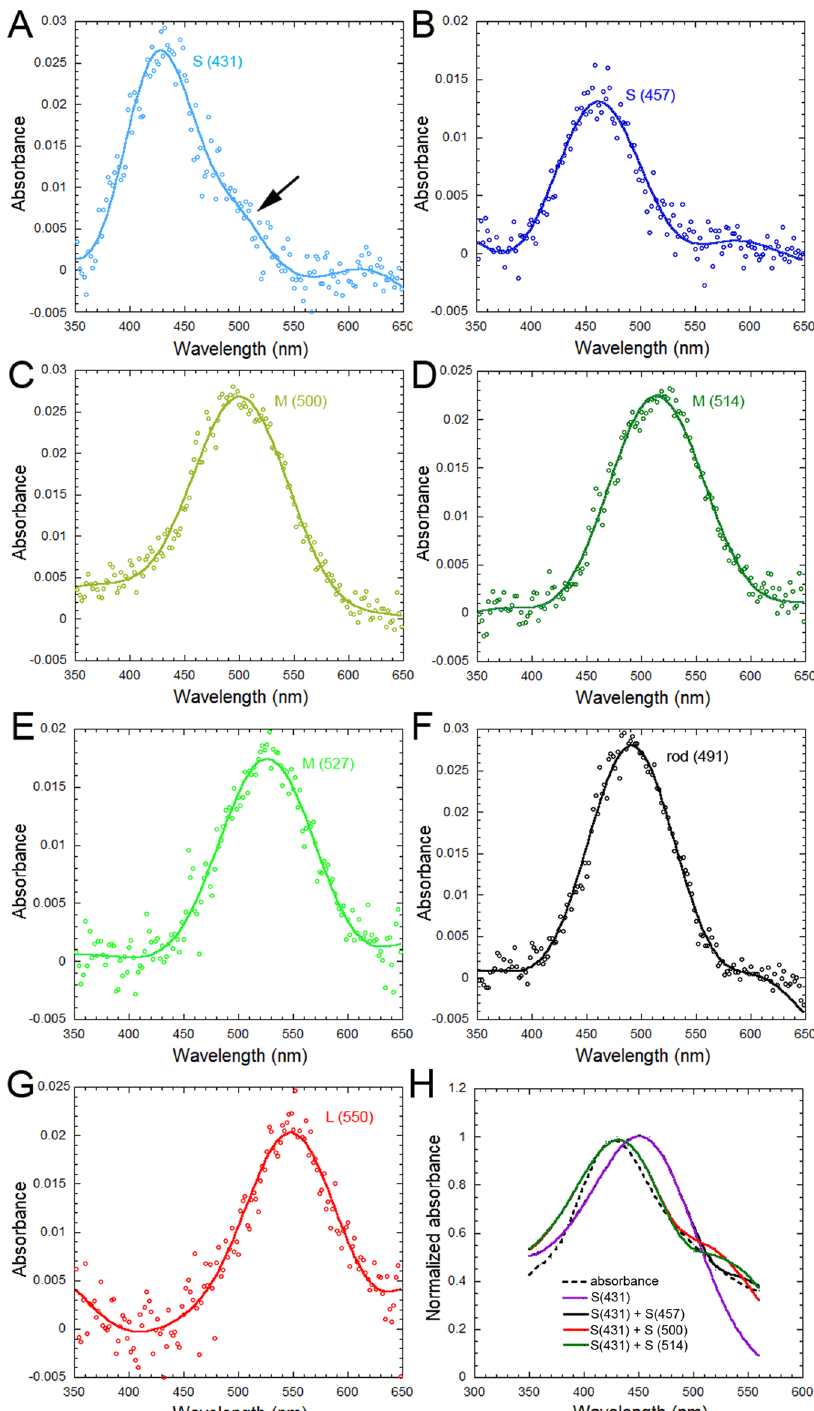
Figure 8. Representative visual pigment absorbance spectra from isolated photoreceptors in the retina of Atlantic halibut juvenile (each trace is the mean of 4–14 records from 4 fish). ( A ) Coexpression of a short wavelength sensitive [S (431)] visual pigment with another visual pigment (as revealed by the “hump” in absorbance at longer wavelengths, black arrow). ( B ) Short wavelength sensitive [S(457)] visual pigment. ( C ) Middle wavelength [M (500)] visual pigment. ( D ) Middle wavelength [M (514)] visual pigment. ( E ) Middle wavelength [M (527)] visual pigment. ( F ) Rod (491) visual pigment. ( G ) Long wavelength sensitive [L(550)] visual pigment. The wavelength of maximum absorbance, λ max , associated with each visual pigment type is in parenthesis. ( H ) Simplex-derived fits to the S(431) absorbance in ( A ) (dotted black function) using one [S(431)] or two visual pigment templates (see Table 1 for corresponding fit